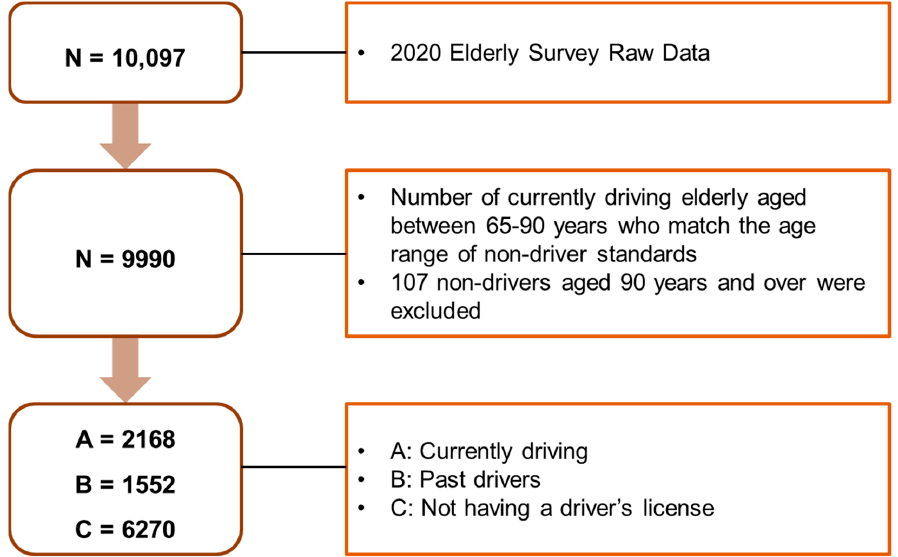
Figure 1. Data cleaning process